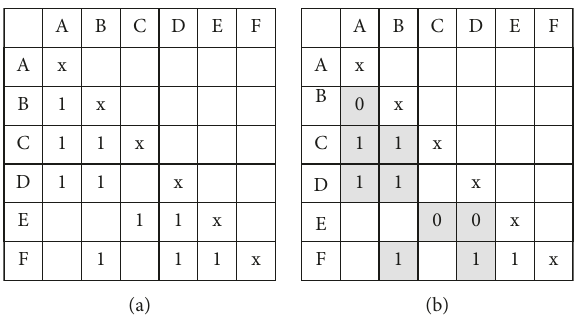
Figure 2: The comparison of OSM and